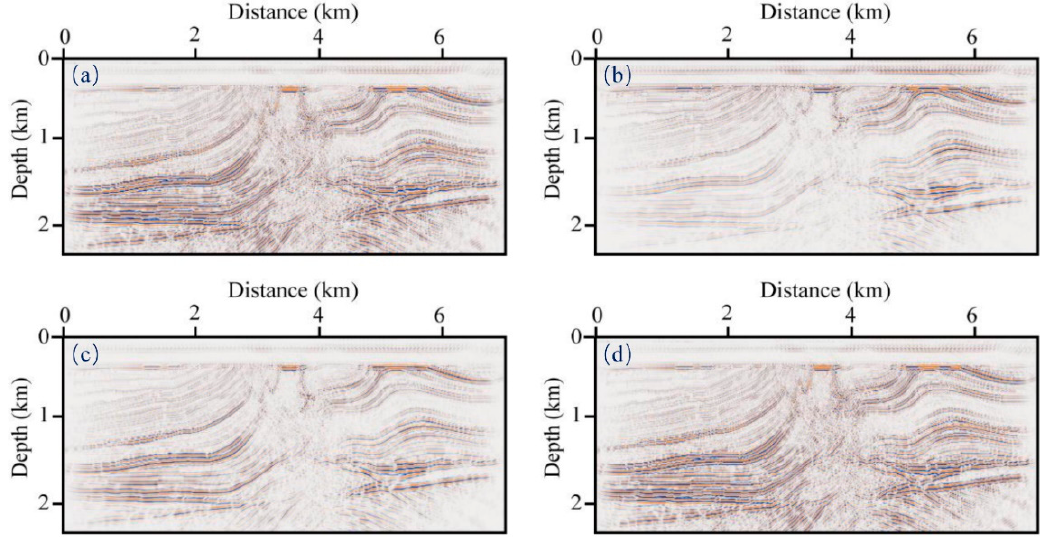
Figure 8. PS-images generated by ( a ) ERTM from lossless seismic data (reference solution), ( b ) non- compensated images, ( c ) Q -compensated with low-pass filter, ( d ) Q -compensated with the proposed a stable scheme.